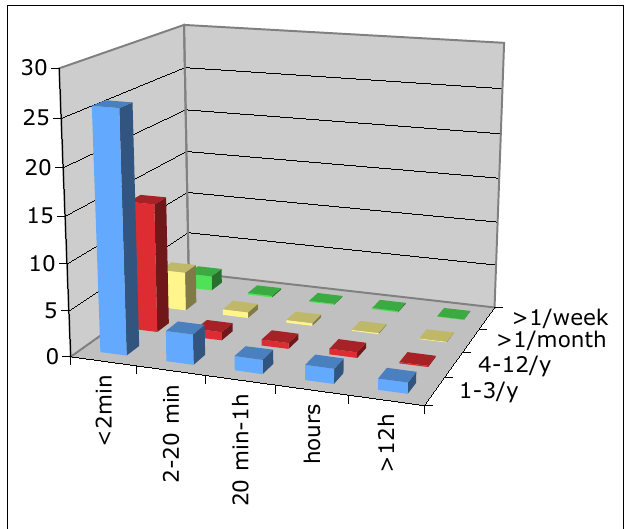
FIGURE 1 |The z -axis represents the prevalence in %, the x -axis the duration of vertigo-episodes, and the y -axis the frequency of vertigo-episodes.